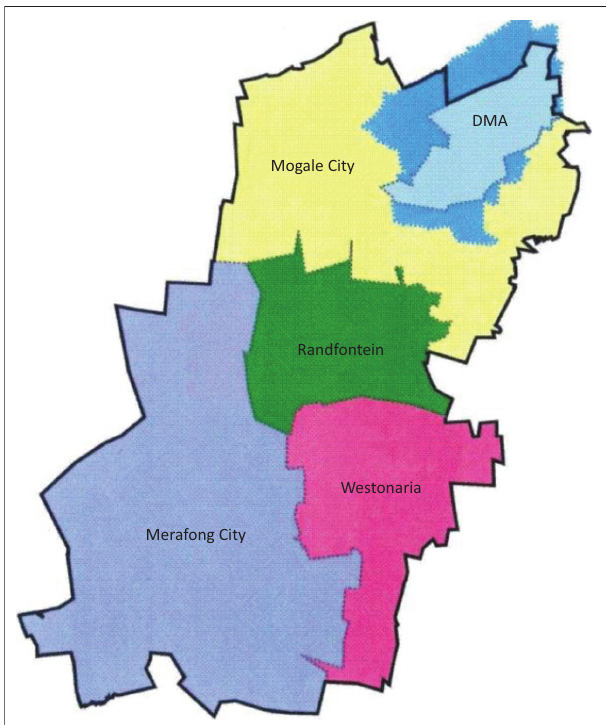
FIGURE 1: Merafong Local Municipality, Gauteng Province, South